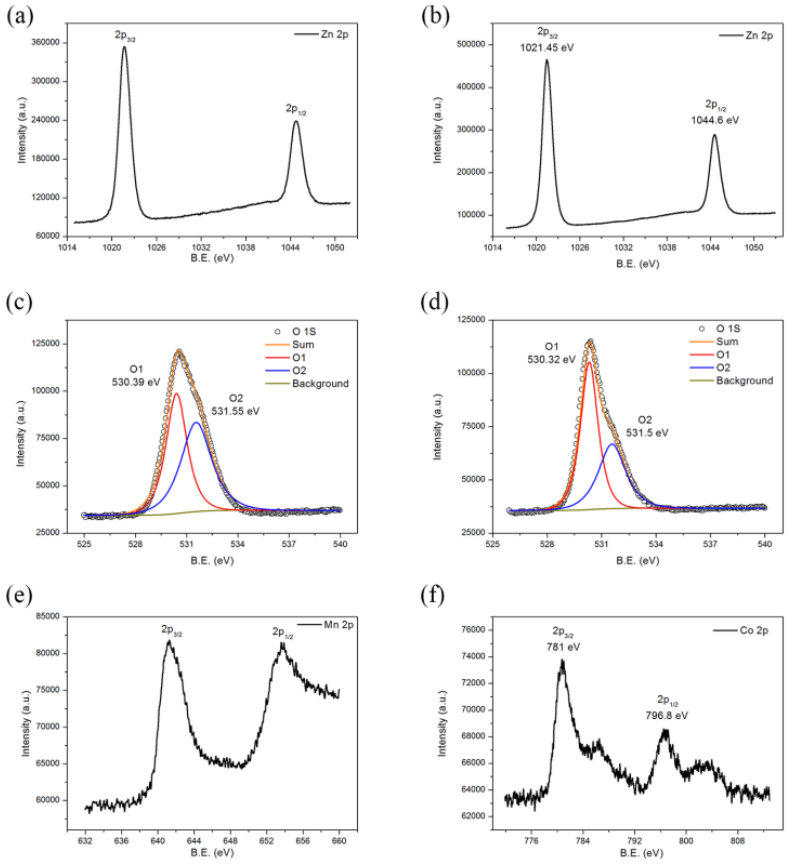
Figure 3. X-ray photoelectron (XPS) spectra of Mn-doped ZnO ( a ) Zn 2p; ( c ) O 1s; ( e ) Mn 2p and Co-doped ZnO ( b ) Zn 2p; ( d ) O 1 s; ( f ) Co 2p.